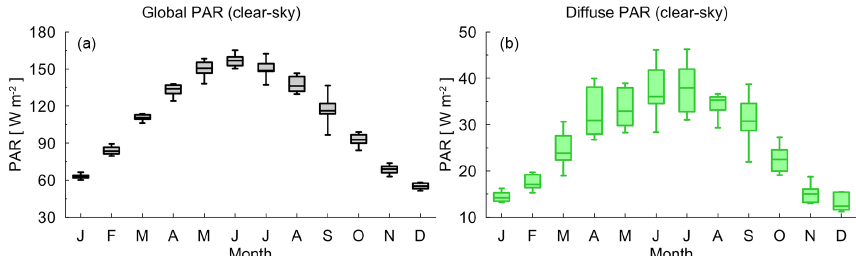
Figure 6. Annual evolution of global (a) and diffuse (b) cloud-free PAR; maxima, upper quartile, median, lower quartile, and minima of the monthly mean are displayed.